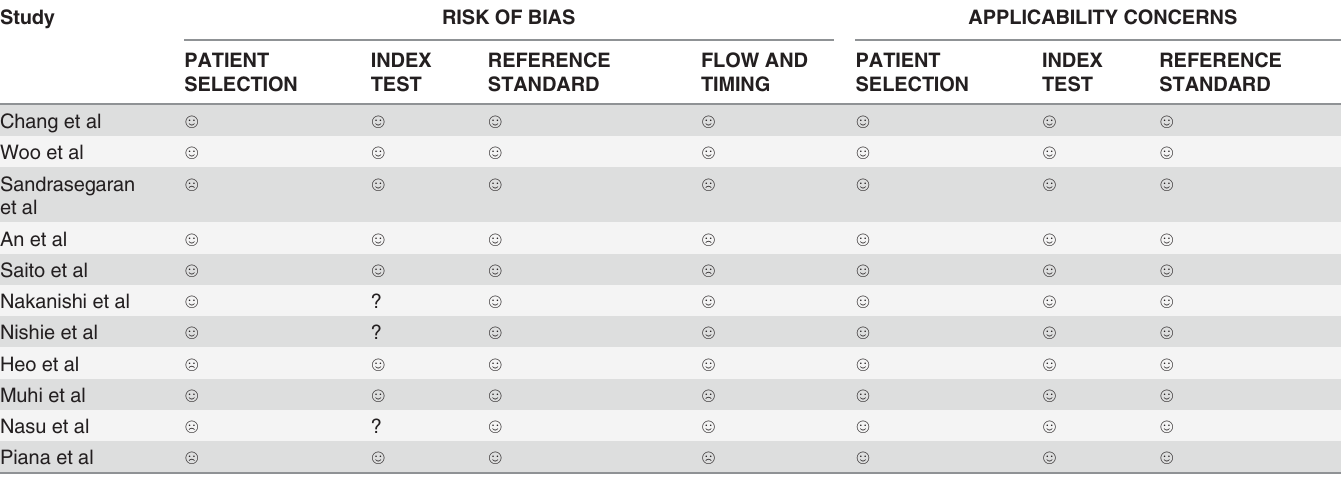
Table 2. Quality assessment of the 11 included diagnostic studies.